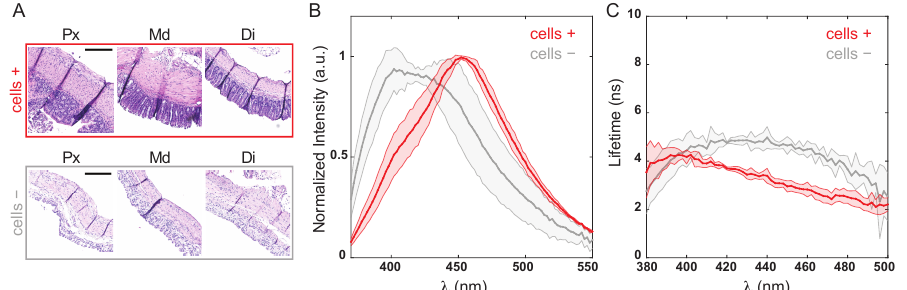
Figure 2. Fluorescence tissue properties of mice colon before (cells +) and after (cells − ) removing endothelial colonocytes. ( A ). Hematoxylin and Eosin (H&E) stain of tissue sections from the proximal (Px), middle (Md), and distal (Di) colon. Scale bar = 200 µ m. ( B ). Normalized autofluorescence emission spectra and ( C ) lifetime